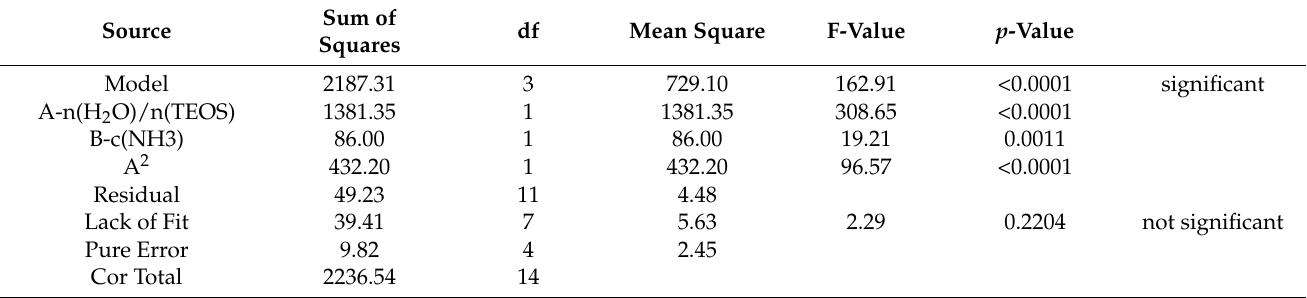
Table A2. Analysis of variance (ANOVA) for the analysis of the FCD design of SiO 2